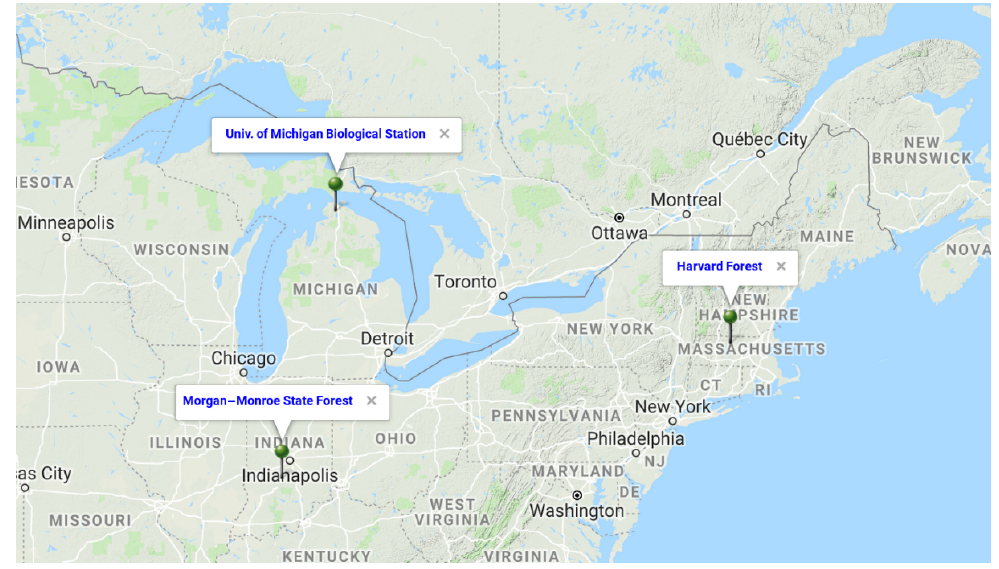
Figure 3. Location of the three FLUXNET sites chosen in this study to evaluate the changes made to the CLASS–CTEM parameterizations aimed to improve leaf phenology. Figure adapted from Google